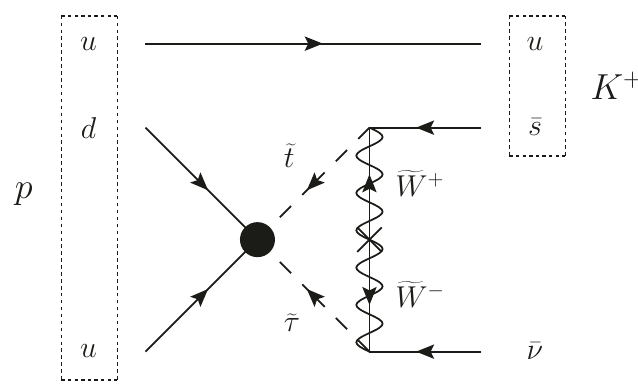
Figure 6 . An example diagram for the proton decay channel p → K + ¯ ν . The big black circle represents the effective dimension 5 operator, and the dressing of this operator takes place by using a mass insertion of the winos f W ±